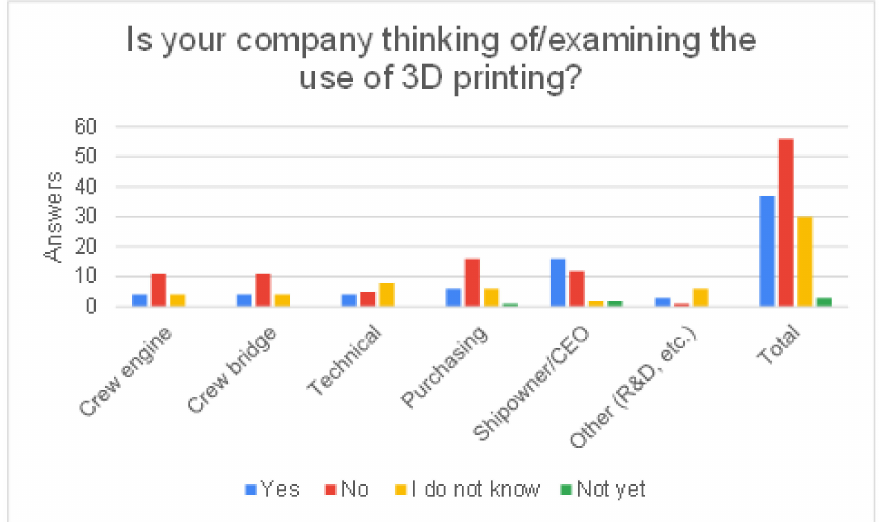
Figure 9. Results for the examination of the use of 3D